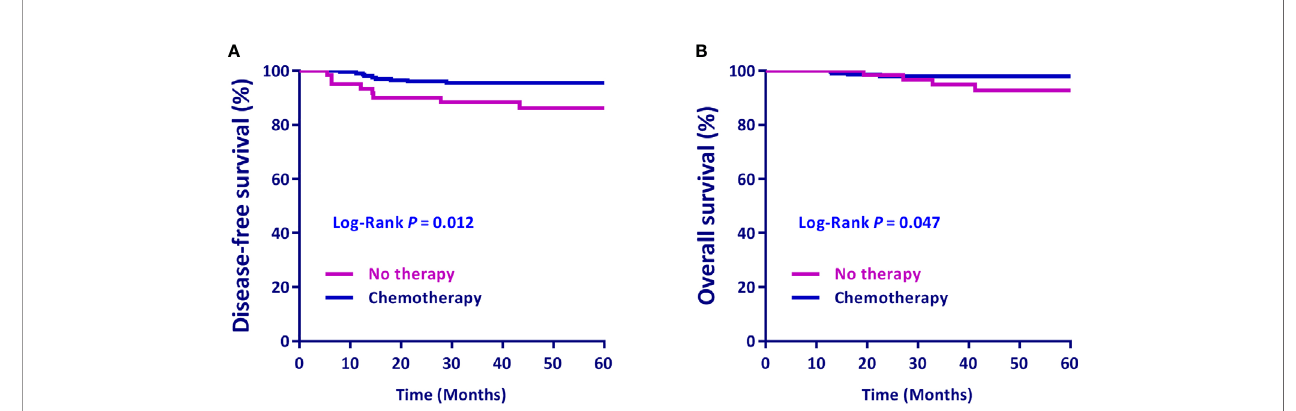
FIGURE 1 | (A) Disease-free survival (DFS) and (B) overall survival (OS) by postoperative treatment. Differences in DFS and OS by treatment were evaluated using the Log-rank test. P < 0.05 was statistically signi fi